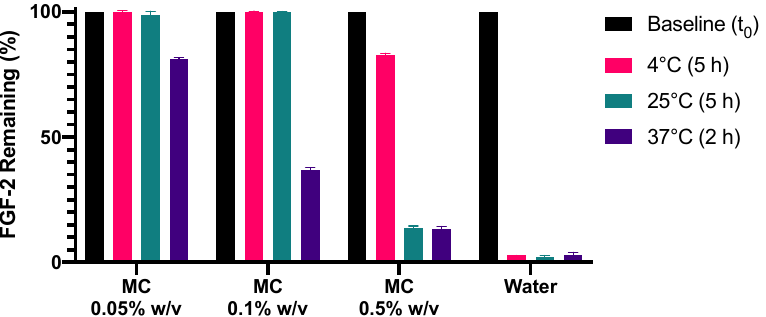
Figure 5. Effect of methylcellulose (MC) concentration on the stability of aqueous FGF-2 solutions (770 ng/mL) incubated at 4 °C for 5 h, 25 °C for 5 h and 37 °C for 2 h. Residual FGF-2 contents following the prescribed incubation period were measured by ELISA and expressed as a percentage of the baseline concentration (mean ± SD, n = 3).